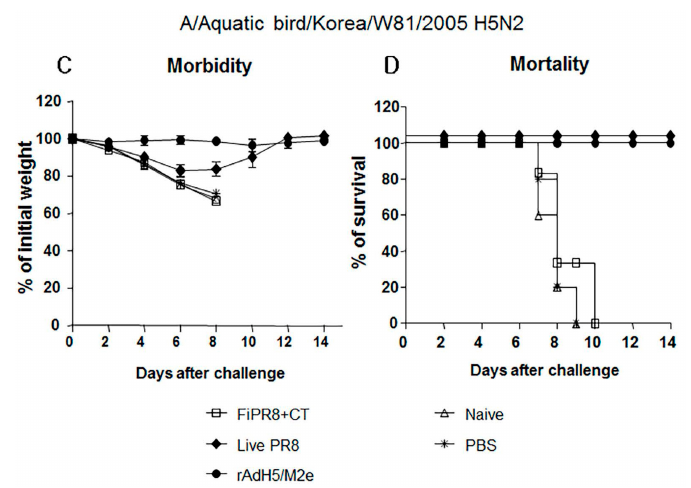
Figure 4. Passive immunization of immune sera from rAdH5/M2e vaccinated mice provided protection against influenza virus challenge infection. Anesthetized Balb/c mice were passively immunized by intranasal administration of sera from mice immunized with FiPR8+CT, live PR8 virus, or rAdH5/M2e vaccine. Control mice received sera from unvaccinated mice or phosphate buffered saline (PBS) only. Six hours later, recipient mice were infected with 5LD 50 of mouse-adapted A/PR/8/34 (PR8) (H1N1) virus ( A , B ) or A/Aquatic bird/Korea/W81/2005 (H5N2) virus ( C , D ). Morbidity and mortality were monitored daily for two weeks after challenge infection. Body weights are expressed as the mean of the percent of starting body weight ± SD. Mortality is expressed as Kaplan-Meier survival curves. Each experimental group consisted of 5 mice per group. The data represent results from three independent experiments of five mice per group. The differences in body weight on days 5 and 6 between the groups immunized with live PR8 or vectored vaccine and formaldehyde-inactivated or unimmunized are statistically significant ( p < 0.001).